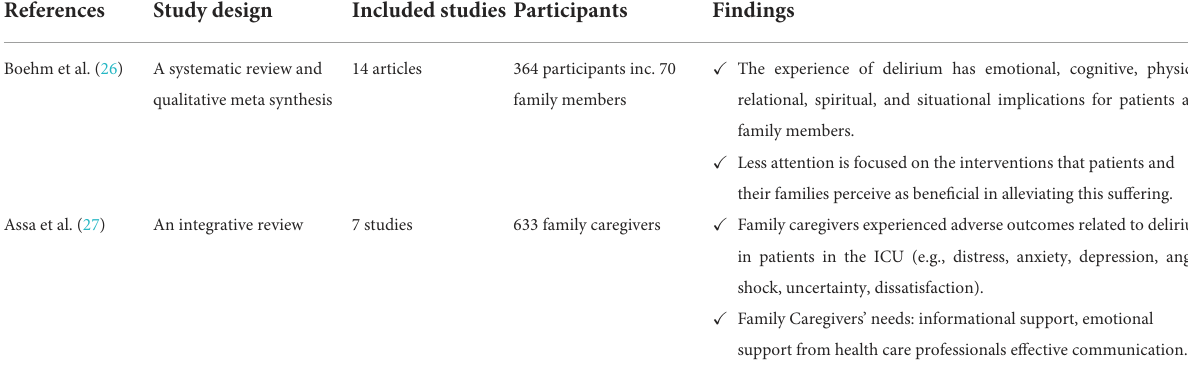
TABLE 3 Characteristics and findings of review study included in scoping